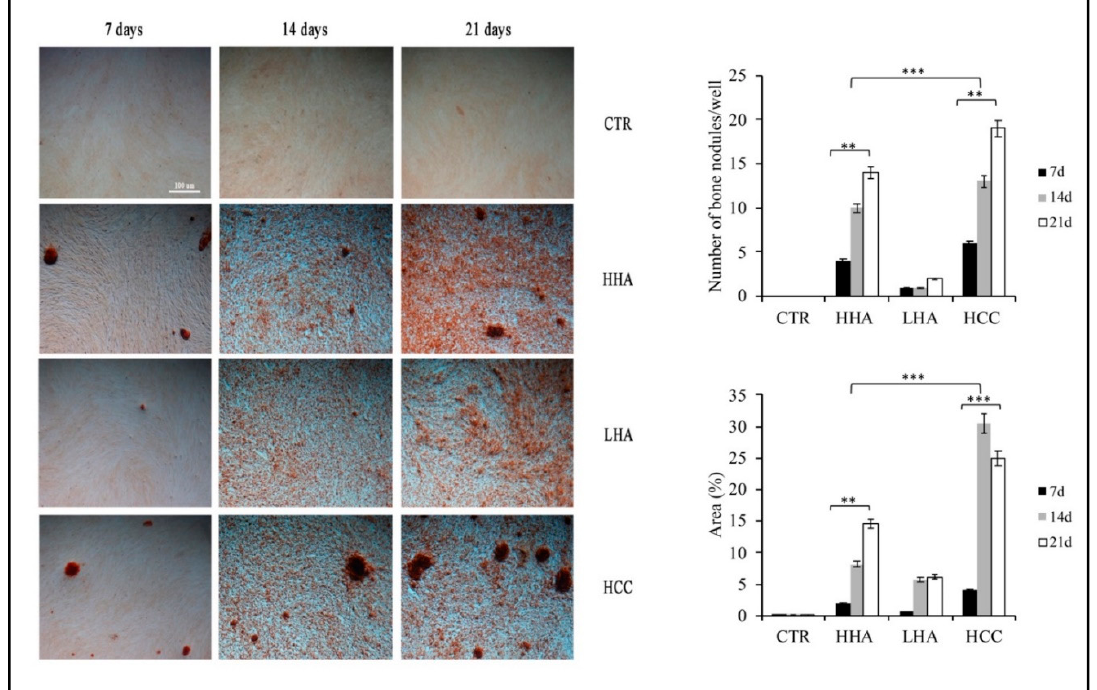
Figure 2. Calcification nodules evaluation at 7,14 and 21 days by Alizarin Red S in standard medium. Already at 7 days, Alizarin Red staining showed the formation of calcification nodules in all treated samples. At 14 and 21 days, HHA and HCC led to a greater number of calcification nuclei compared to LHA and control. This was confirmed also by calculating the percentage area of positive staining. The results are expressed as the mean ±SD of three independent experiments. ** p < 0.01 HHA vs. CTR, *** p < 0.001 HCC vs. CTR; *** p < 0.001 HHA vs. HCC.